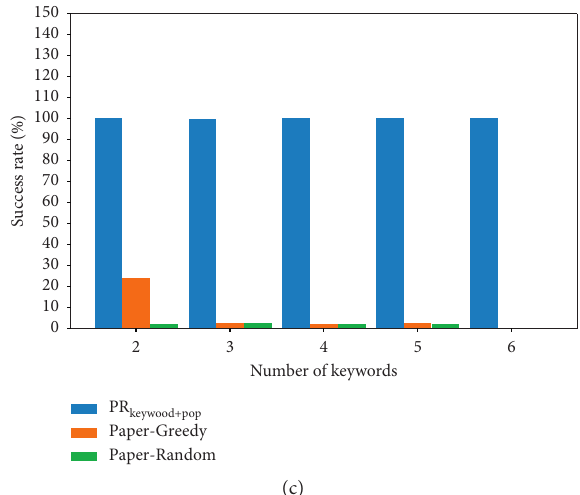
Figure 9: The success rate of different approaches: (a) set A, (b) set B, and (c) set C.